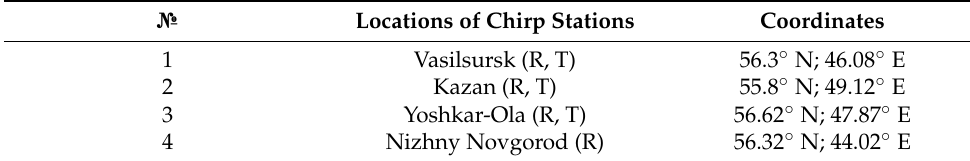
Figure 1. Paths’ network for diagnosing the ionosphere using chirp signals. Table 1. Coordinates of chirp stations.